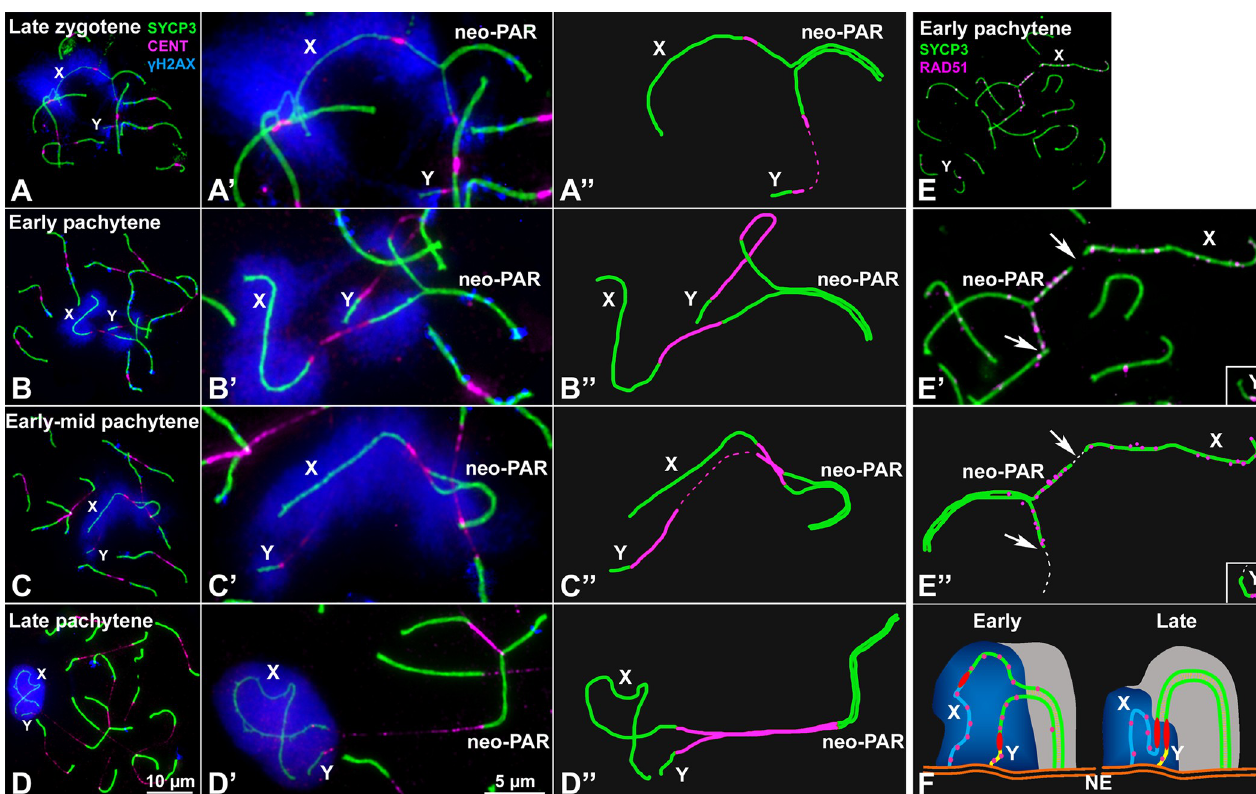
Fig 2. Synapsis and DNA repair in the sex chromosomes. A-D” . Spread spermatocytes in prophase-I labelled with antibodies against SYCP3 (green), centromeres (magenta) and γ H2AX (blue). Non-homologous segments of the sex chromosomes (X, Y) and the neo-PAR are indicated. A-A” . Zygotene. Most autosomes have completed synapsis. Enlarged view of the sex chromosomes ( A’ ) and their schematic representation ( A” ). Both the non-homologous segments and a large portion of the neo-PAR are unsynapsed and labelled with γ H2AX. In some cases, centromeres are so elongated that the signal is very weak (represented as dashed lines). B-B” . Early pachytene. Autosomes have fully synapsed but sex chromosomes still have not completed synapsis in the neo-PAR. The centromeres appear greatly stretched. C-C” . Mid-pachytene. Synapsis in the sex chromosomes has extended but still is not complete. D-D” . Late pachytene. The neo-PAR has completely synapsed. Although the non-homologous segments of the sex chromosomes remain unsynapsed, they are in close proximity, forming a single chromatin mass that is strongly labelled with γ H2AX. E-E” . Details and schematic representation of a sex bivalent from an early pachytene spermatocyte labelled with antibodies against SYCP3 (green) and RAD51 (magenta). The proximal regions of the neo-PAR are unsynapsed and accumulate RAD51 foci. The non-homologous segments also accumulate RAD51. Arrows and dashed lines (in E”) indicate putative centromere positions. F . Schematic representation of synapsis and DNA repair in the sex chromosomes. neo-PAR AEs/LEs are represented in green, AEs of X and Y differential segments are represented in blue and yellow respectively, centromeres in red, TFs in yellow, RAD51 in pink, chromatin in grey, γ H2AX in blue and nuclear envelope (NE) in orange. At early pachytene, synapsis proceeds from the distal end of the neo-PAR; however, compared with autosomes, it is delayed. Unsynapsed regions accumulate DNA repair proteins (pink foci). As synapsis proceeds, the X chromosome bends to allow the complete synapsis of the neo- PAR. Repair proteins are also removed from the neo-PAR but remain on the unsynapsed non-homologous segments.